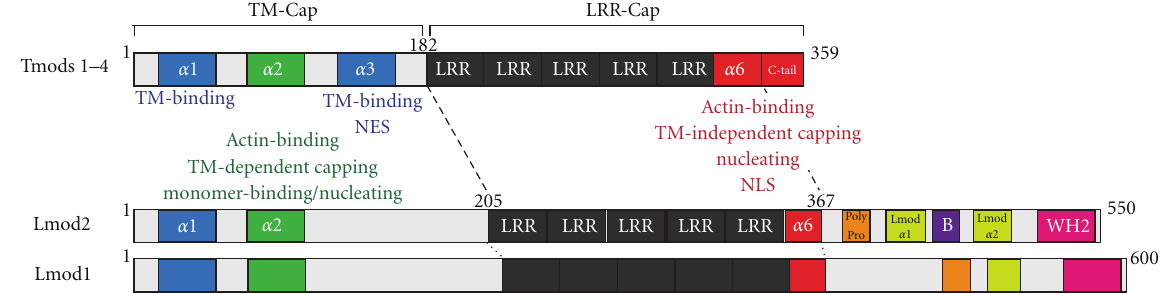
Figure 1: Schematic of the molecular sequence and domain organization of Tmods and Lmods found in vertebrate striated muscle. Tmods contain an N-terminal TM-Cap domain and a C-terminal LRR-Cap domain, whose α -helices possess distinct combinations of TM-binding and actin-regulatory activities, as shown. The α -helices are numbered sequentially within each domain, and the NES and NLS of Tmods are highlighted. Lmods also contain a C-terminal extension with a polyproline region, two predicted α -helices, a basic region, and a WH2